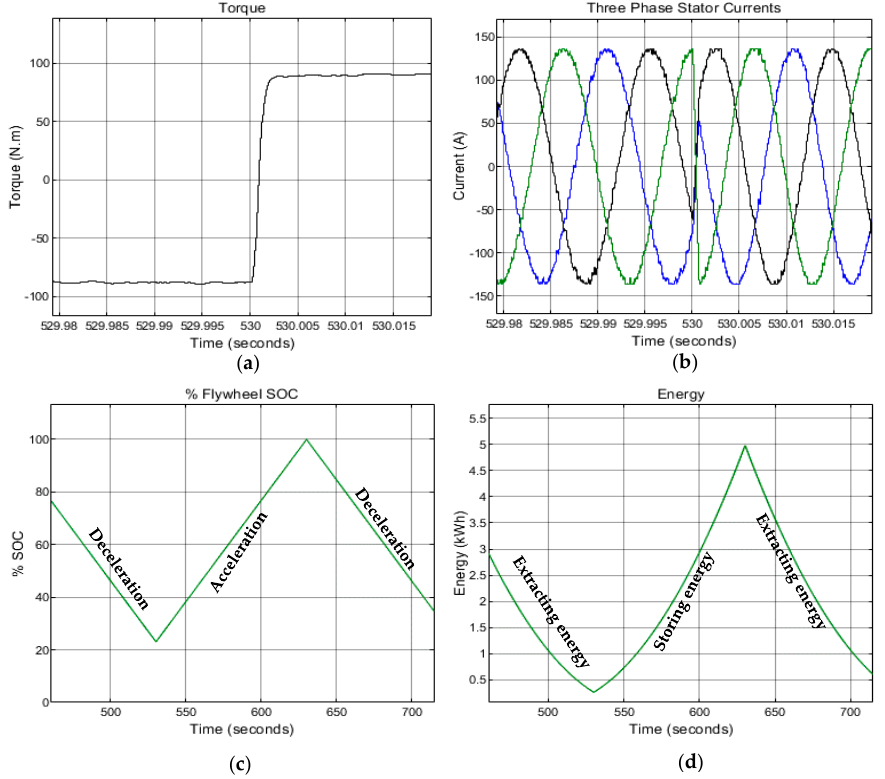
Figure 9. ( a ) Torque at t = 530 s; ( b ) Magnified three phase currents; ( c ) %SoC at t = 530 s; ( d ) stored energy in kWh